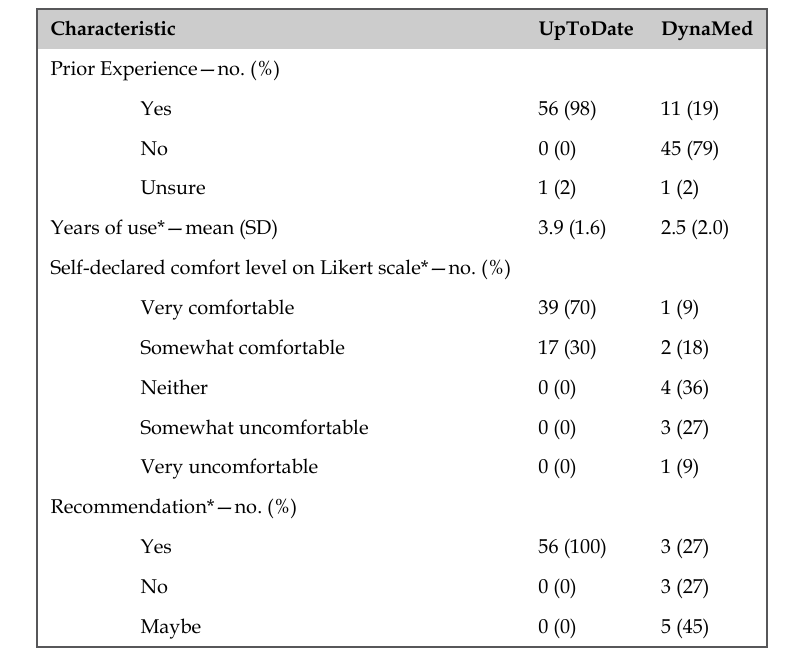
Table 2 Baseline information for participant experience and use of POCI tools Characteristic UpToDate DynaMed Prior Experience—no. (%) Yes 56 (98)